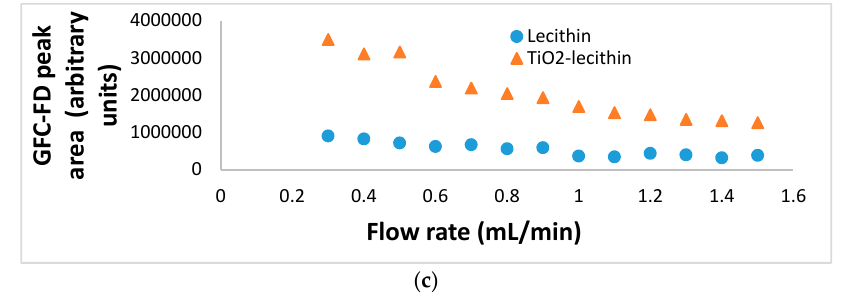
Figure 8. Effects of flow rate on ( a ) retention times, ( b ) retention volumes, and ( c ) peak areas of lecithin liposomes and lecithin liposome-encapsulated TiO 2 nanoparticles (1.0 mg/mL) in extended GFC-FD analysis, using λ ex,max = 350 nm and λ em,max = 395 nm for FD.